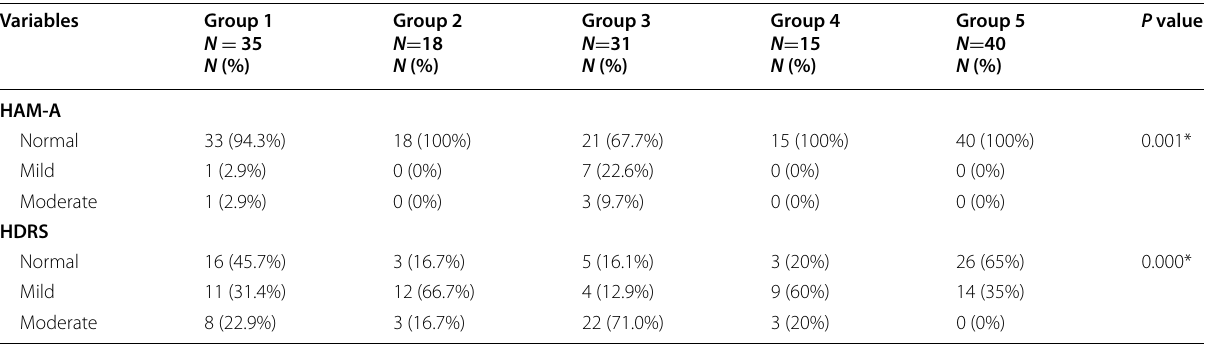
Table 6 The Hamilton Anxiety Rating Scale (HAM-A) and Hamilton Depression Rating Scale (HDRS) among the studied samples